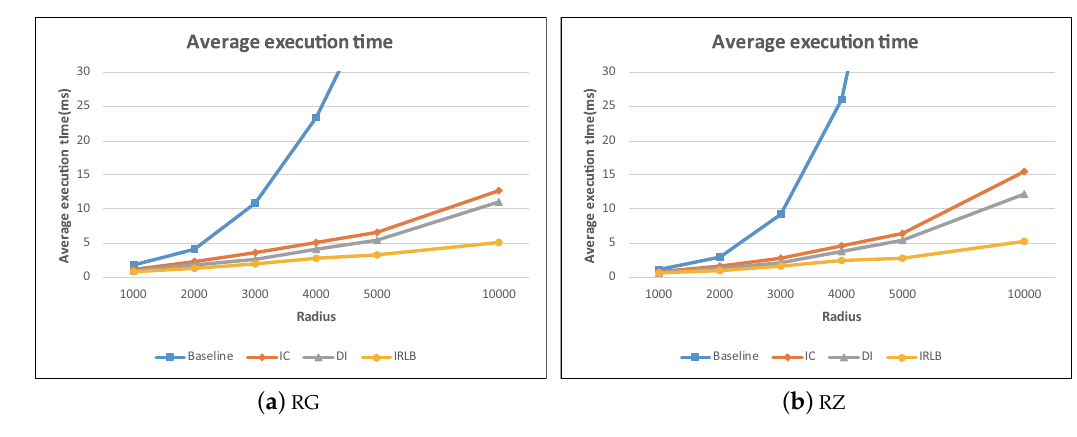
Figure 27. Average execution time vs. θ .